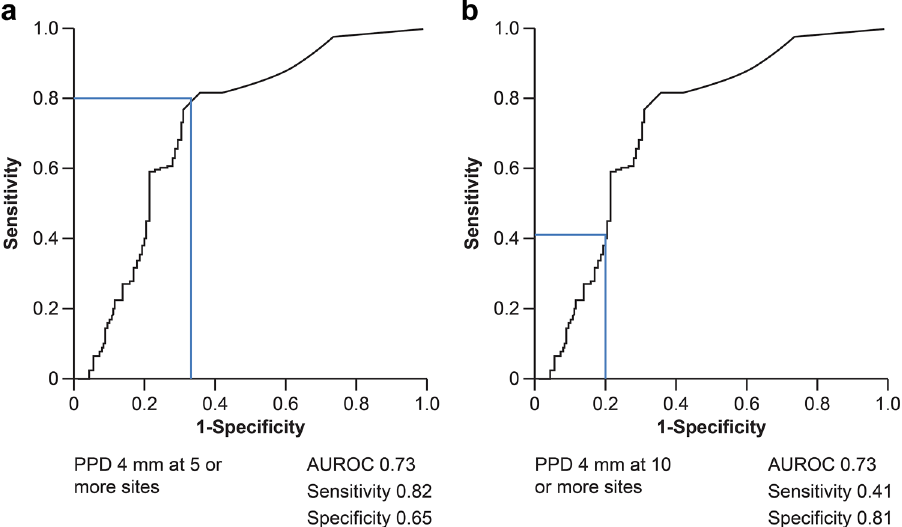
Figure 4. AUROC curves for patients with PPDs ≥ 4 mm at ≥ 5( a ) and ≥ 10 ( b ) sites. AUROC area under the receiver operating characteristic, PPD periodontal pocket